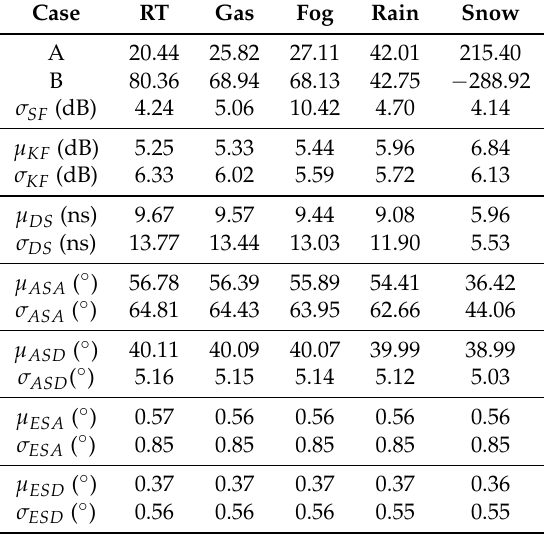
Table 3. Channel parameters by different meteorological